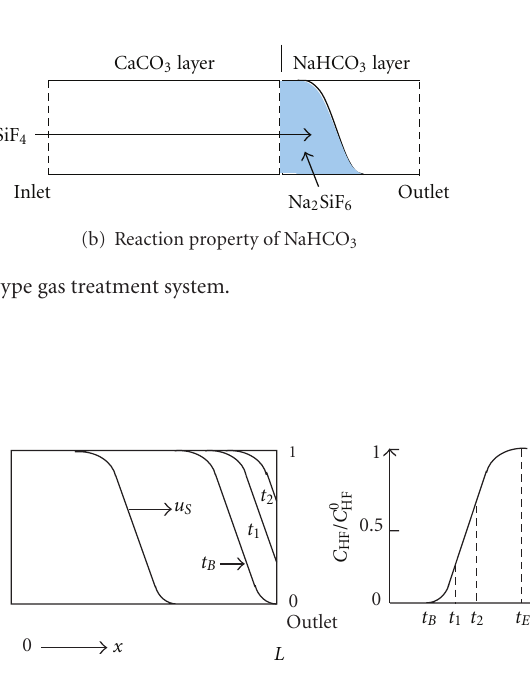
Figure 5: Breakthrough curve as compared with inside phe- nomenon on fixed-bed